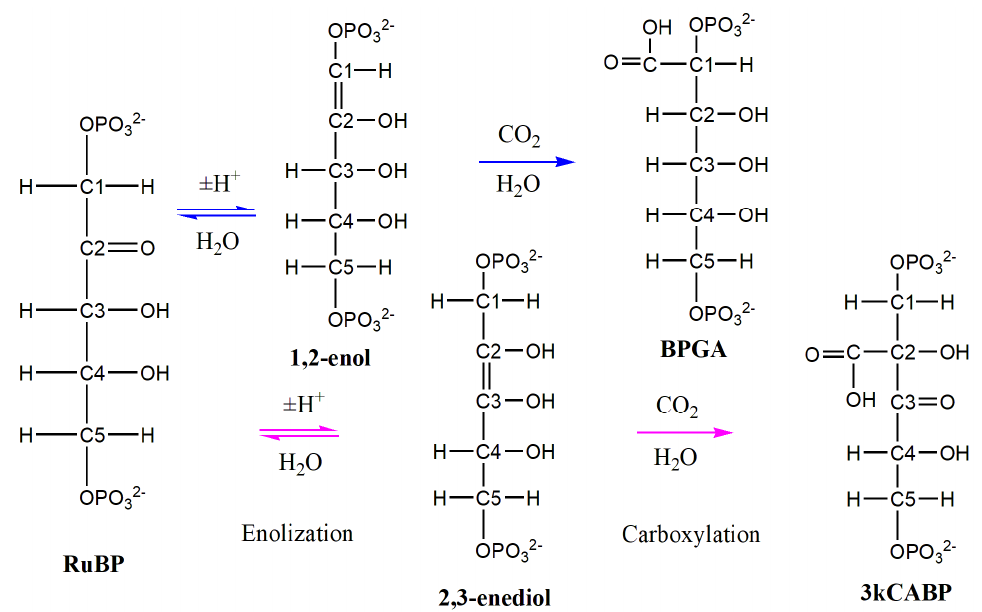
Figure 1. Pathways of enolization and carboxylation reactions via carbon atoms C 1 (blue) and C 2 (purple). Table 1. Electronic and energy characteristics of the studied molecules. The total charge of the molecule, Q; multiplicity, M; charges on atoms, q C1 , q C2 , q C3 ; total energy, E 0 (eV); Gibbs free energy, G 0 (eV); energy of the highest occupied molecular orbital, E HOMO (eV); energy of the lowest unoccupied molecular orbital, E LUMO (eV). No Molecule